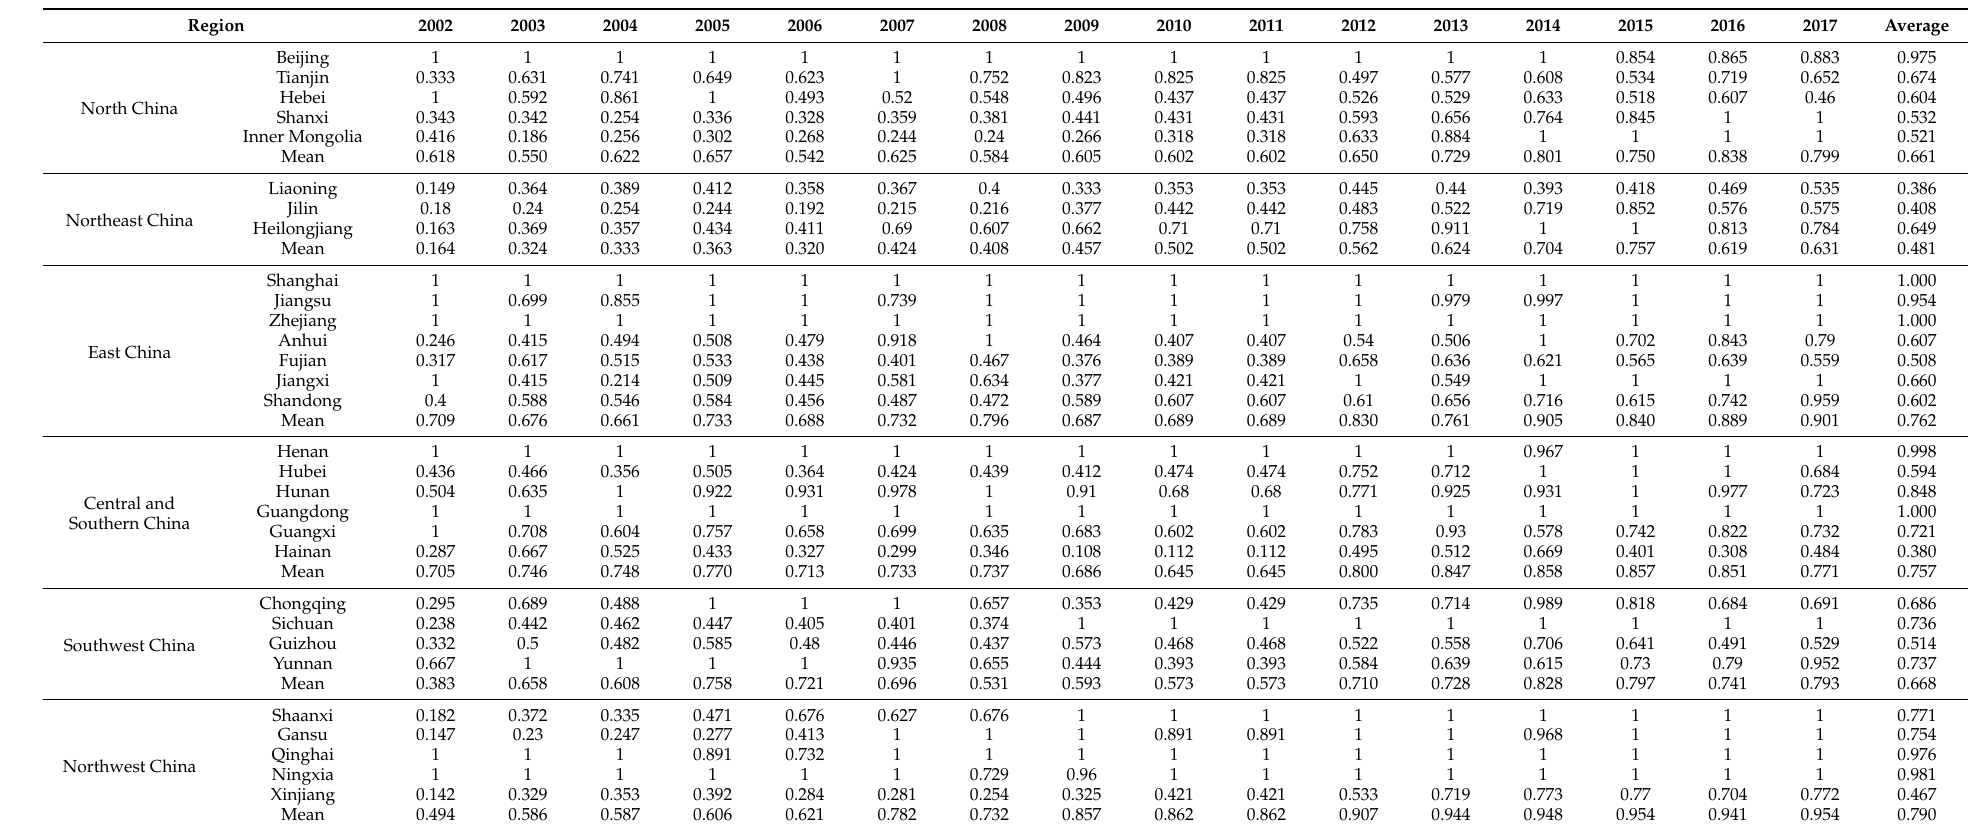
Table A1. The first stage pure technical efficiency results from BCC